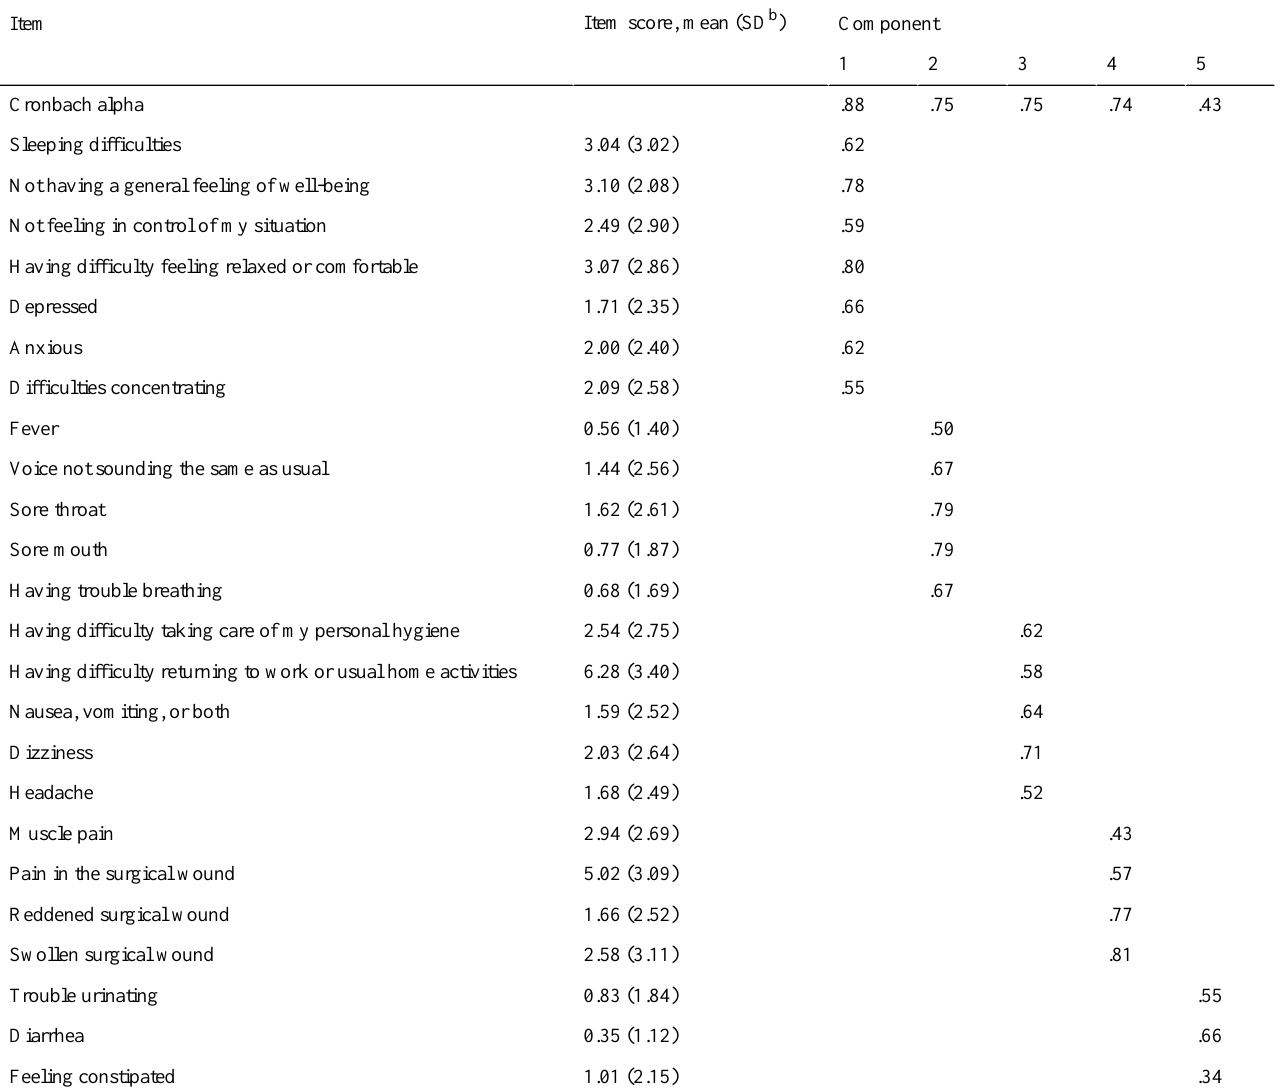
Table 3. Item mean scores and factor loadings of SwQoR a day 1, by exploratory factor analysis and Cronbach alpha.